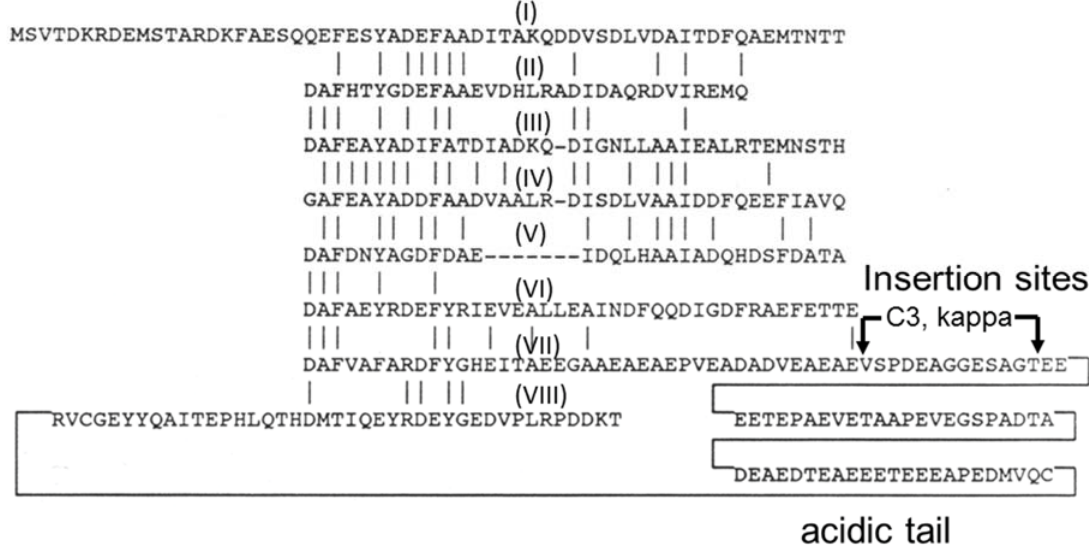
Figure 2. Amino acid sequence of GvpC from Halobacterium sp. NRC-1 showing internal repeats (numbered by Roman numerals I–VIII) with identities indicated by vertical lines. The location of insertion sites (C3 and kappa ) used for gene fusions, and acidic tail near the C-terminal region are